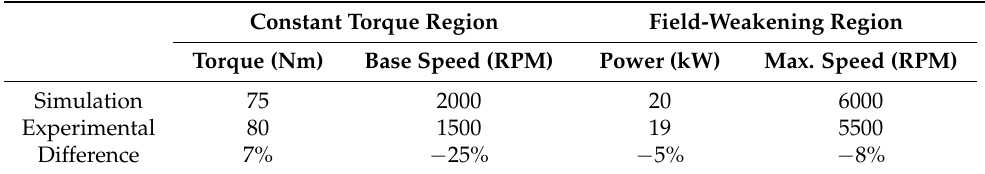
Table 3. Performance comparison of the IPMSM and its proposed lookup table-based